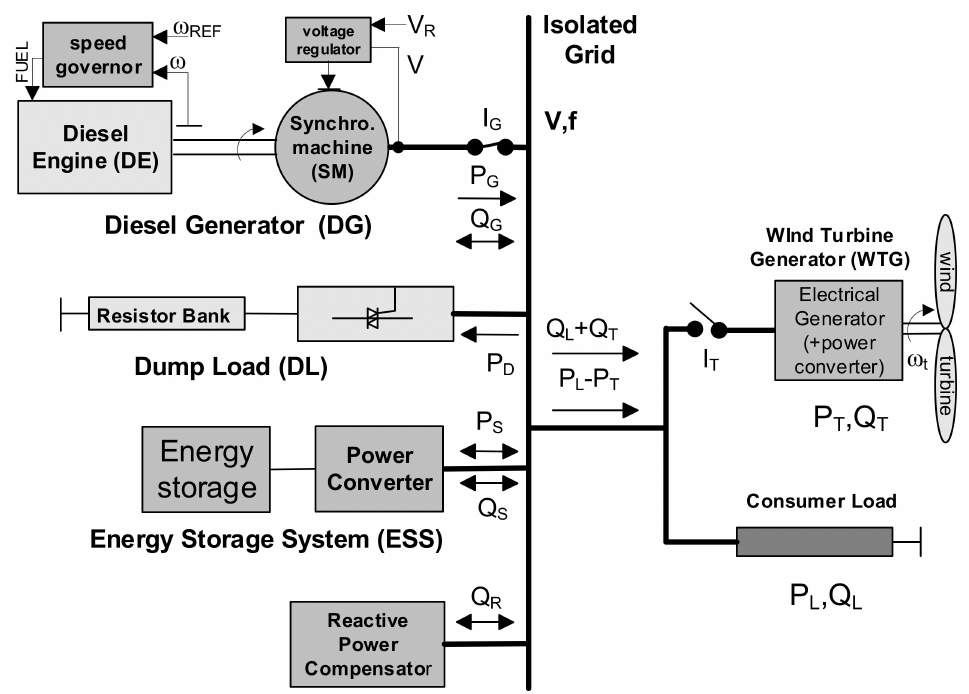
Figure 1. Wind diesel isolated microgrid